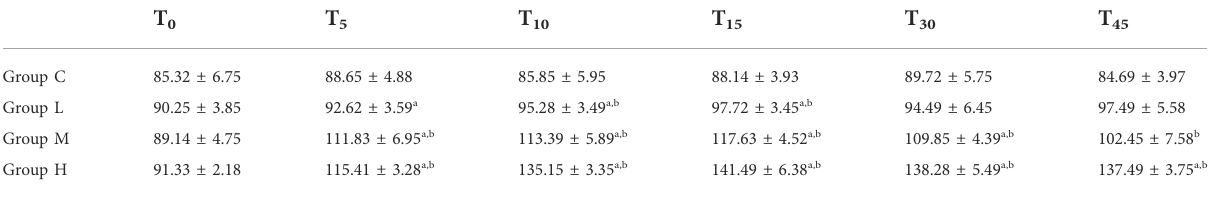
TABLE 1 Hemodynamic parameters of rabbits between groups (mean arterial pressure, MAP, mm Hg, data are expressed as means ± SD, n = 30 for each group).